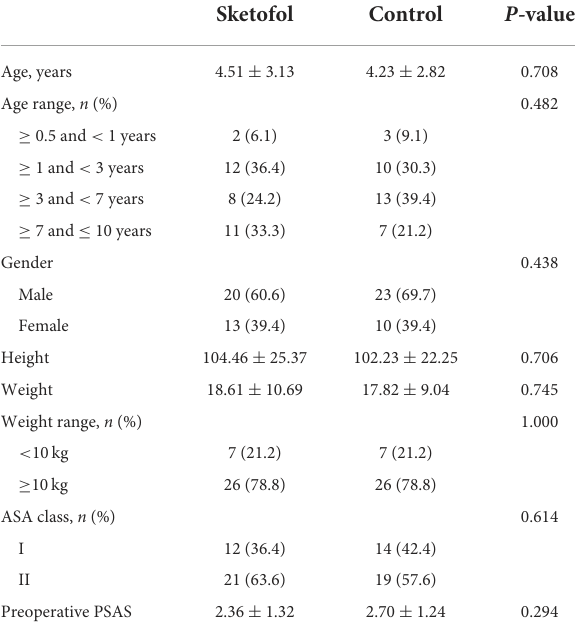
TABLE 2 Subject characteristic data.